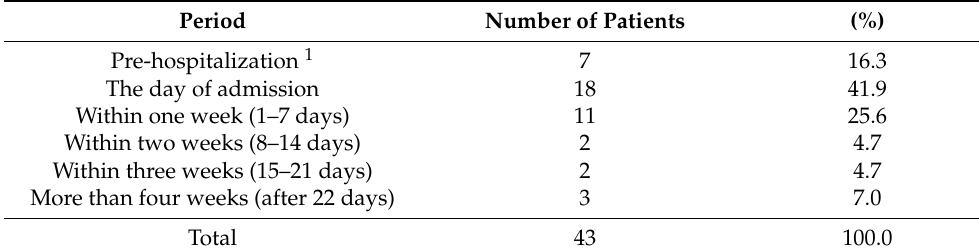
Table 5. The period from admission to the date of the self-harm attempt.